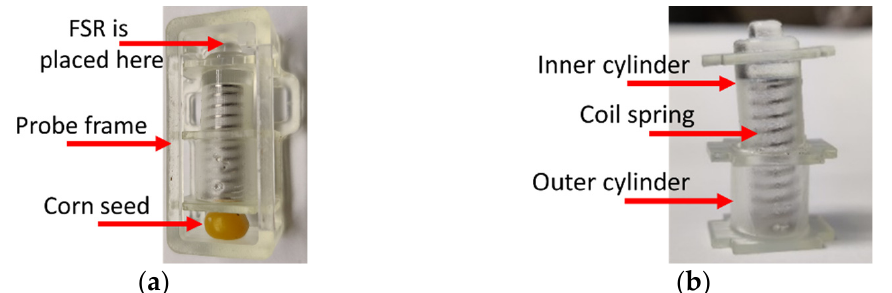
Figure 4. Flowchart of the measurement process in the proposed design.